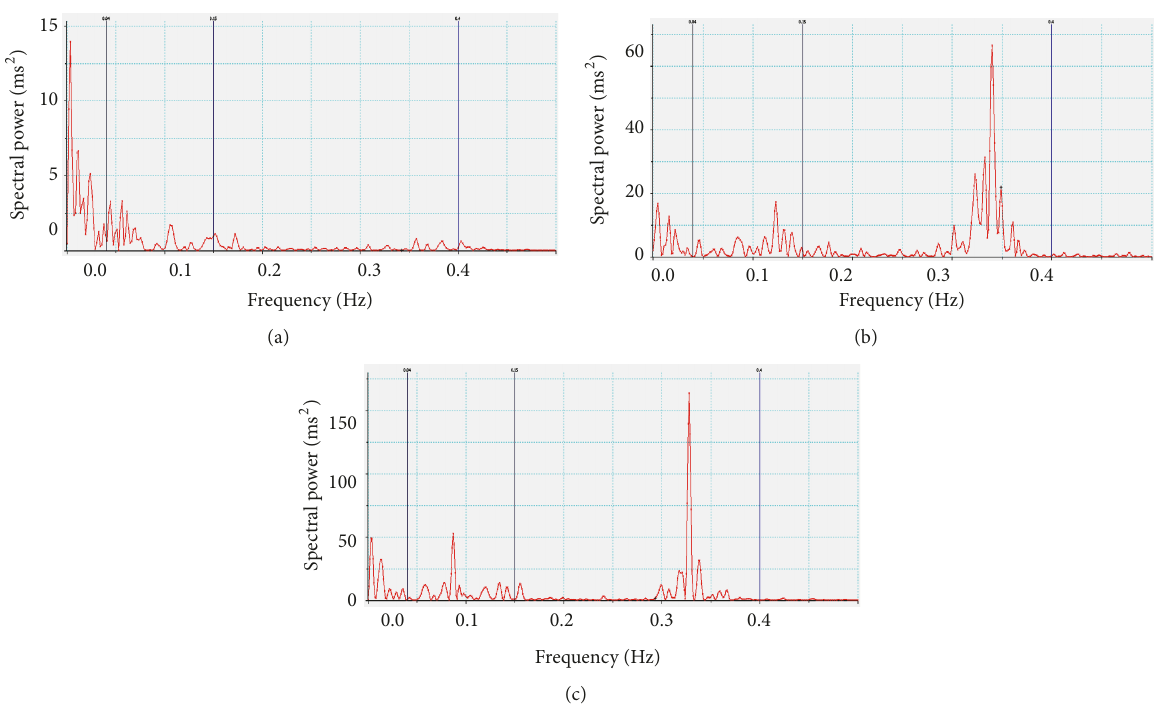
Figure 2: Spectral power of heart rate for different groups. (a) Preeclamptic females; (b) normotensive pregnant females; (c) normal nonpregnant